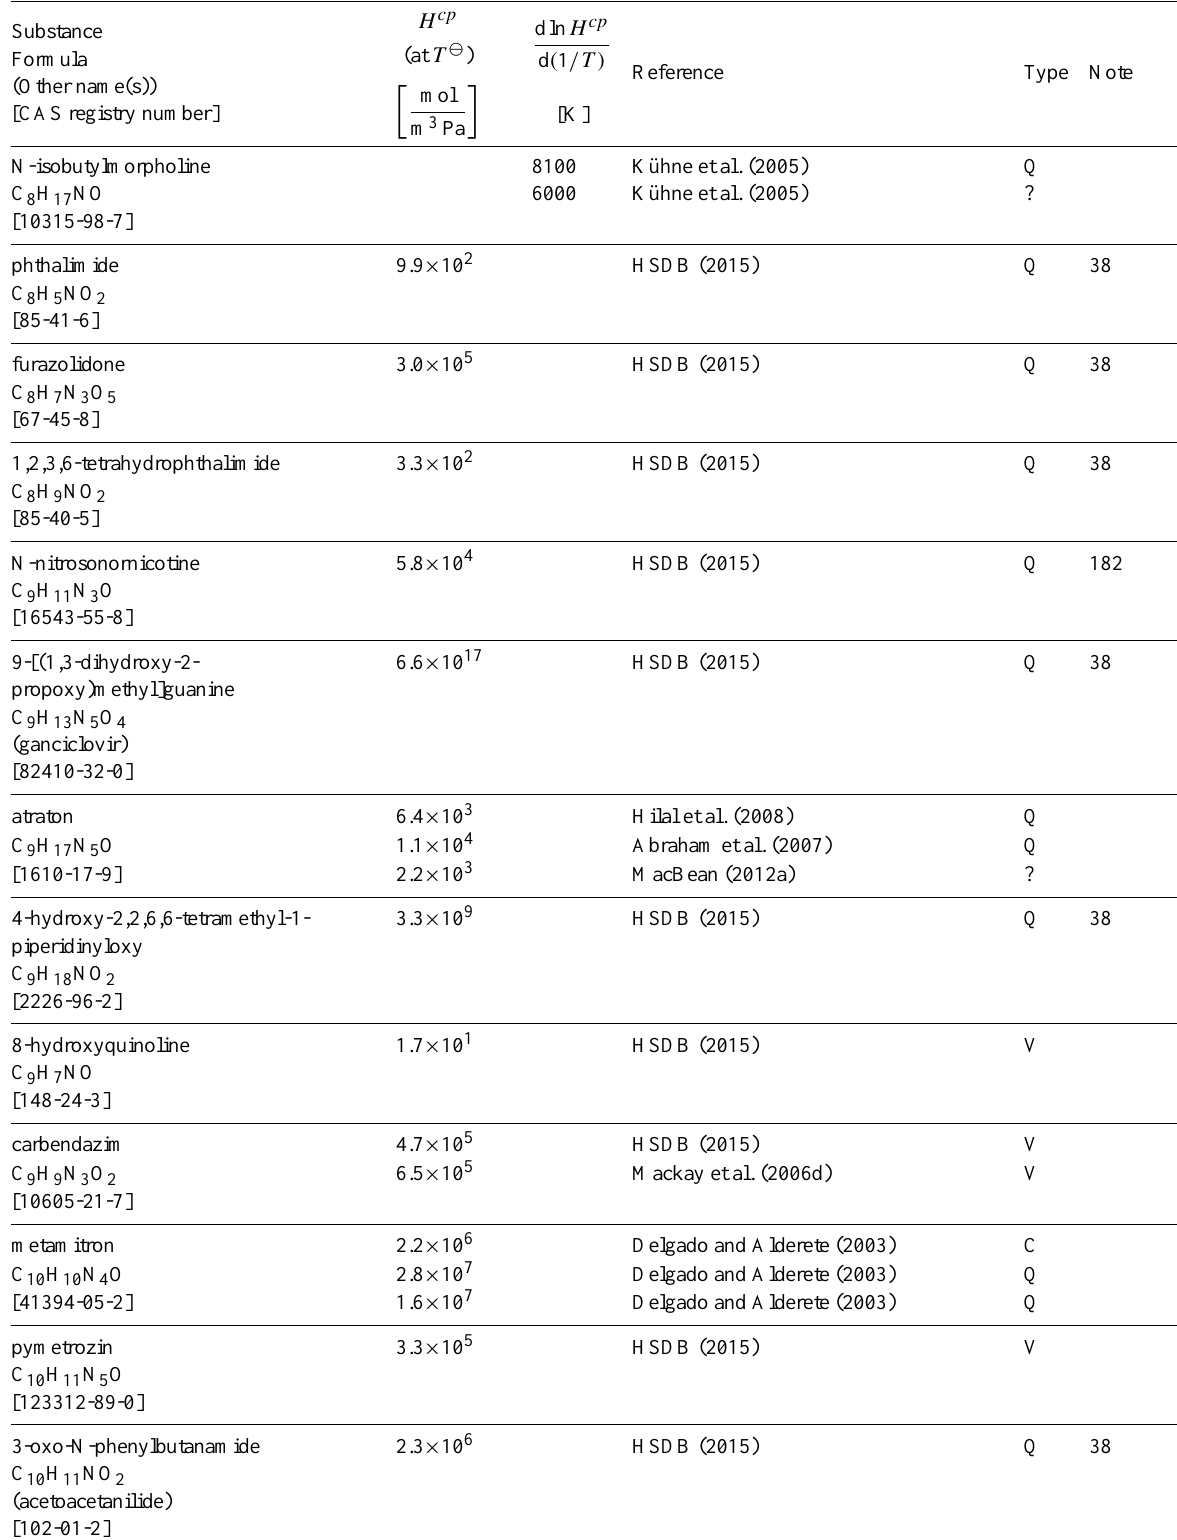
Table 6: Henry’s law constants for water as solvent